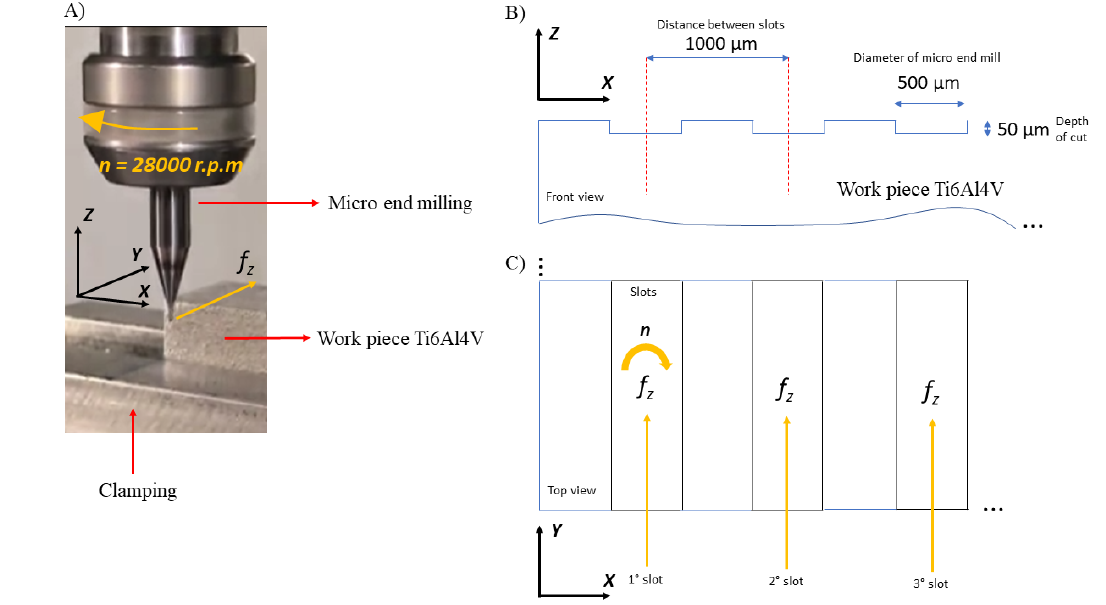
Figure 2: Configuration for slot cutting. A) General view and cutting parameters. B) Geometry of the channels in the front view and C) Top